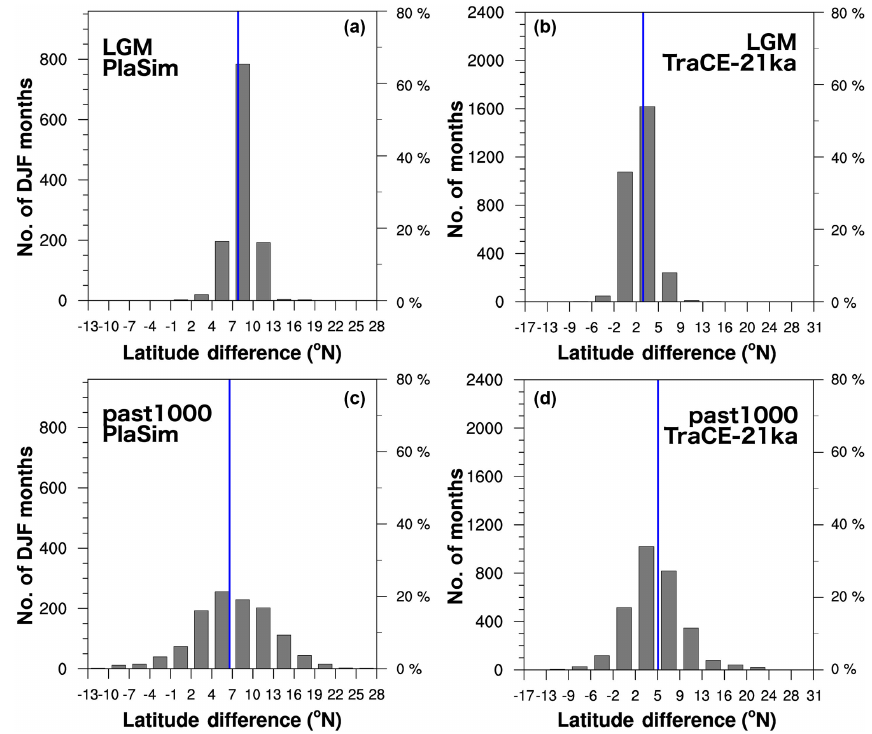
Figure 8. Histograms of jet tilt for the PlaSim ensemble (a, c) and TraCE-21ka fully transient simulation (b, d) over indicated periods. Vertical blue lines mark the mean jet tilt for each period.